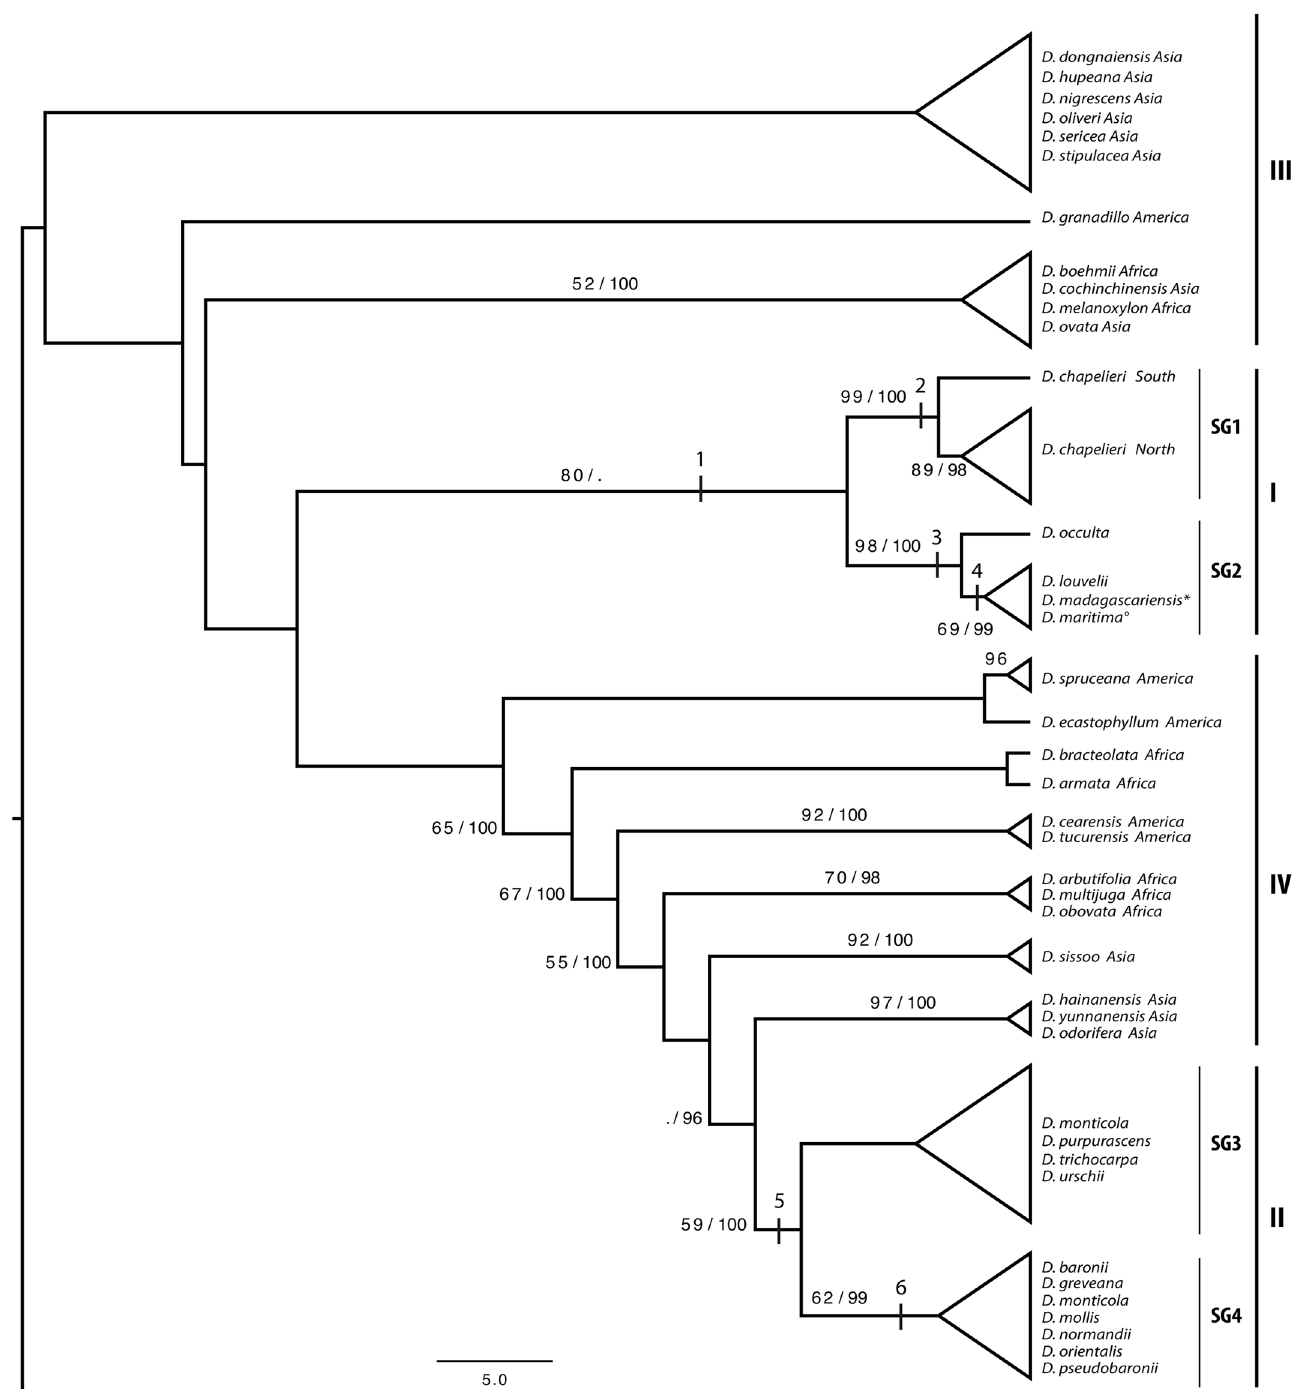
Fig 2. Phylogenetic tree of studied Dalbergia species. Malagasy Dalbergia species are divided into two main groups, I and II, encompassing three well-supported subgroups (SG1, SG2 and SG4). Only subgroup 1 (SG1) encompasses all samples from a single species, D . chapelieri , All other subgroups encompass accessions from more than one species. Vertical black bars indicate positions of diagnostic polymorphisms (Table 2) along the phylogenetic tree. Numbers above branches are bootstrap support values / posterior probabilities derived from maximum likelihood (ML) and Bayesian analyses, and are shown only when values are above 50 and 94, respectively. Shown is the tree topology derived from the ML analysis. For non-Malagasy Dalbergia , the geographic origin (continent) of each species is indicated. * D . madagascariensis subsp. antongilensis ; ° D . maritima var. pubescens